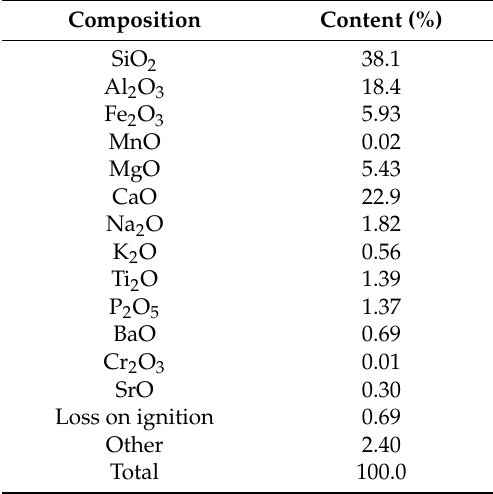
Table 2. Composition of fly-ash amendment in filter media layer of bioretention cells in Grove, OK,